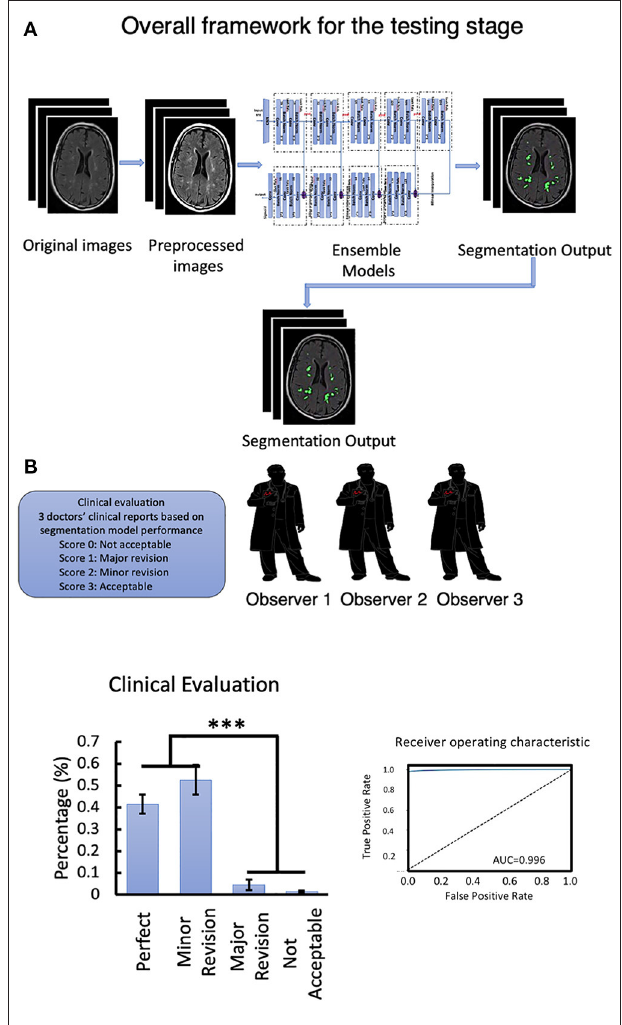
FIGURE 5 | (A) Overall framework for the testing stage. (B) Clinical evaluation of the testing data set and Segmentation model ROC-curve and AUC score analysis. Number of neuroradiologists are 3. *** P <